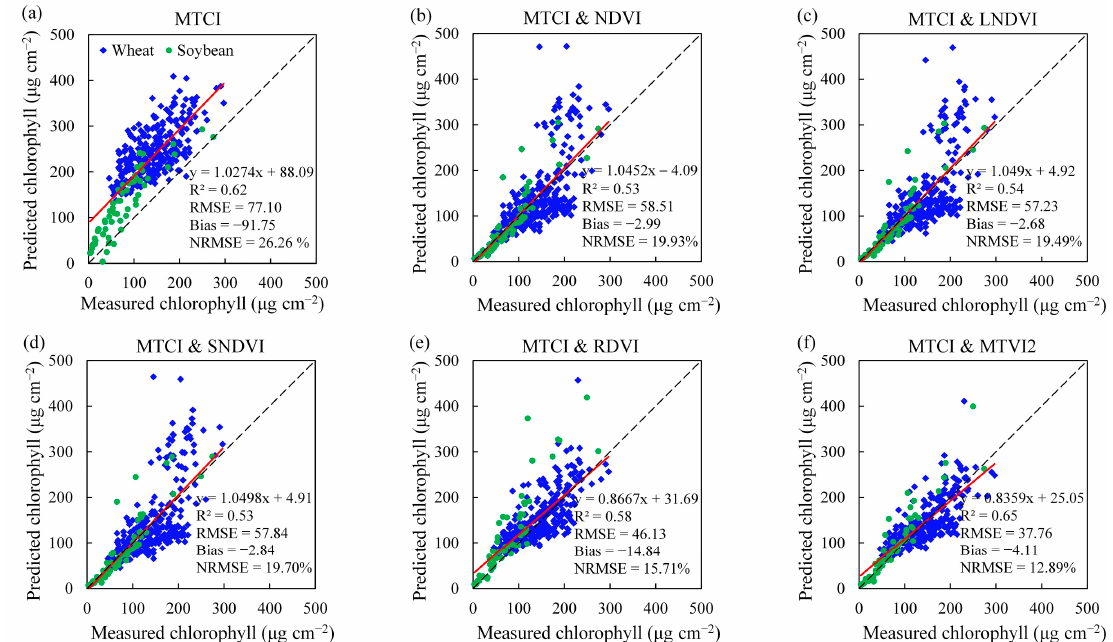
Figure 9. The CCC retrieval accuracy for soybeans and wheat when using the RFR method with field spectrum data: ( b ) MTCI and NDVI; ( c ) MTCI and LNDVI; ( d ) MTCI and SNDVI; ( e ) MTCI and RDVI; ( f ) MTCI and MTVI2. The performance of a single MTCI in a linear regression model is displayed in ( a ) for comparison.